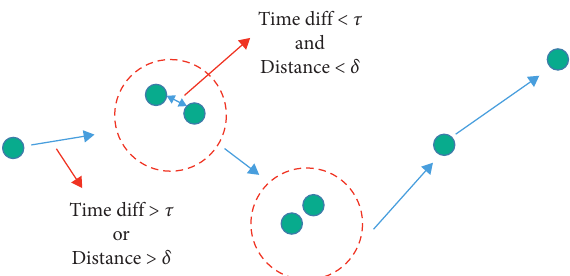
Figure 2: Illustration of STCS method handling small-scale ping- pong